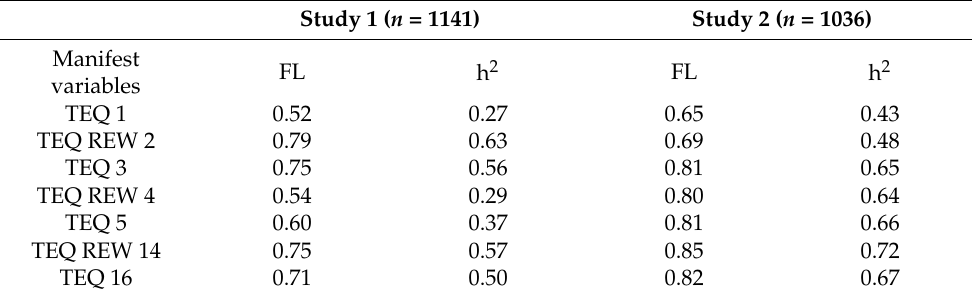
Table 4. Factor Loadings and communalities in two CFA studies.